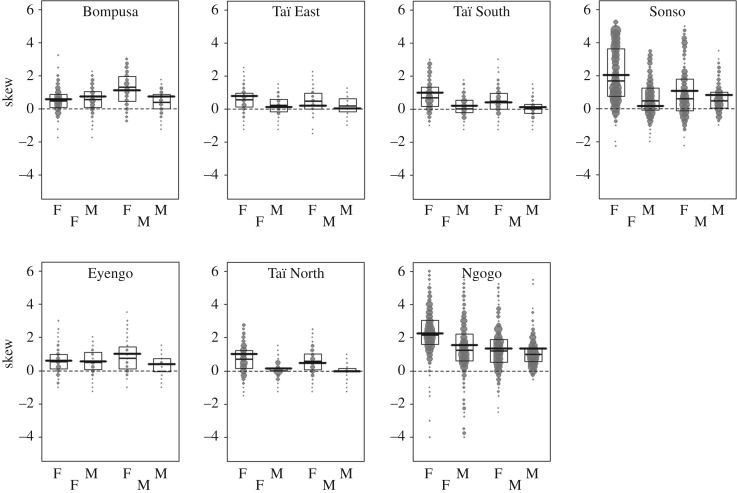
Differentiation (SKPAv) of association values for individuals of a given sex (M and F at the lower part of each graph) towards members of the sex indicated above (for each graph from left to right: females towards females, females towards males, males towards females and males towards males). Higher values indicate stronger skew reflecting fewer top associates. Each dot represents an individual and the area of the dot is proportional to the number of quarters (or years) it was observed. The thin black horizontal line indicates the median of the raw data and the thick black horizontal line indicates the fitted value for each sex combination based on the output of Model 3. The black box indicates the first and third quartile of the data in each sex combination for each community.